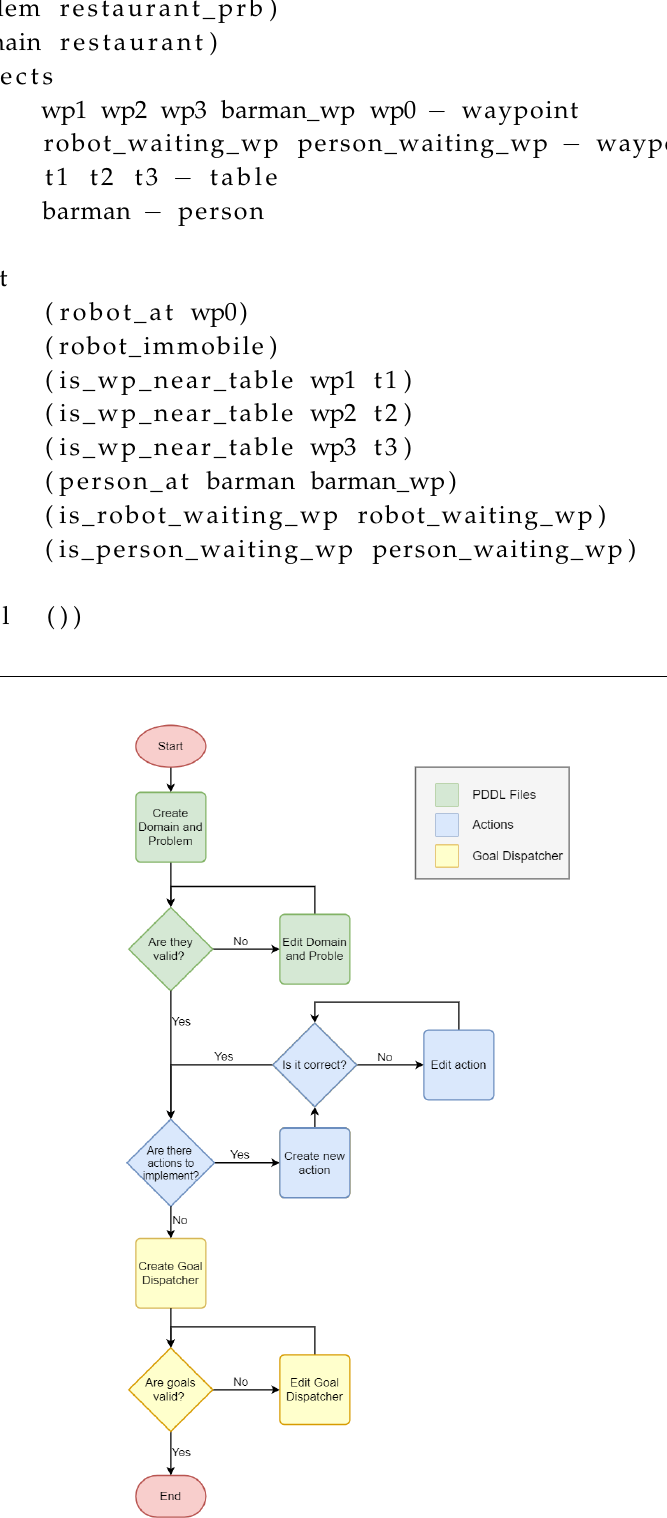
Figure 6. Programming flowchart to create new behaviors using